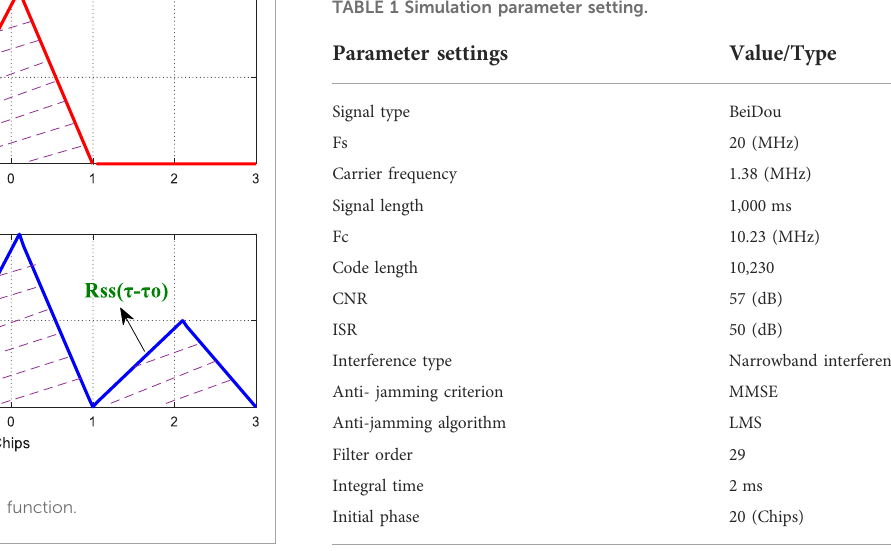
TABLE 1 Simulation parameter setting.